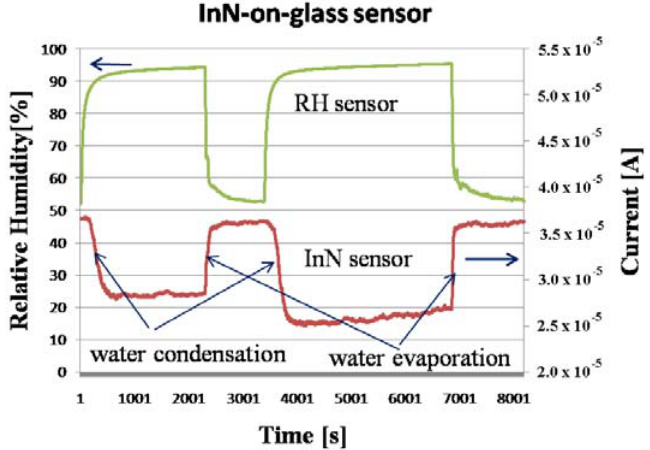
Figure 4. Current behavior during water condensation and evaporation for the InN-on-glass sensor.